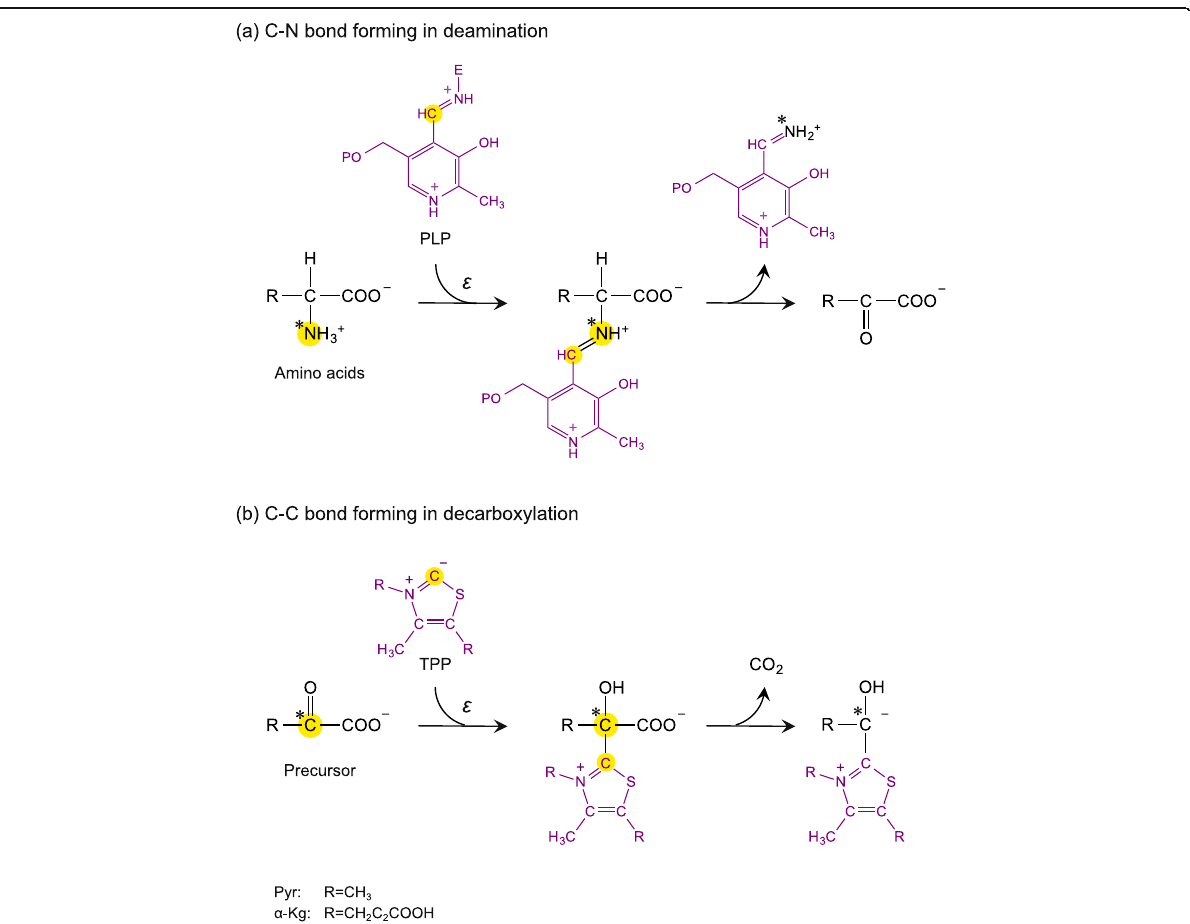
Fig. 4 a Possible scenarios of the isotopic fractionation during deamination of amino acids and b decarboxylation of pyruvic and α -ketoglutaric acids: the fractionation is caused by forming of C-N or C-C bond. Asterisk indicates atoms where isotopic fractionation occurs. Yellow highlight indicates reaction points accompanied with the isotopic